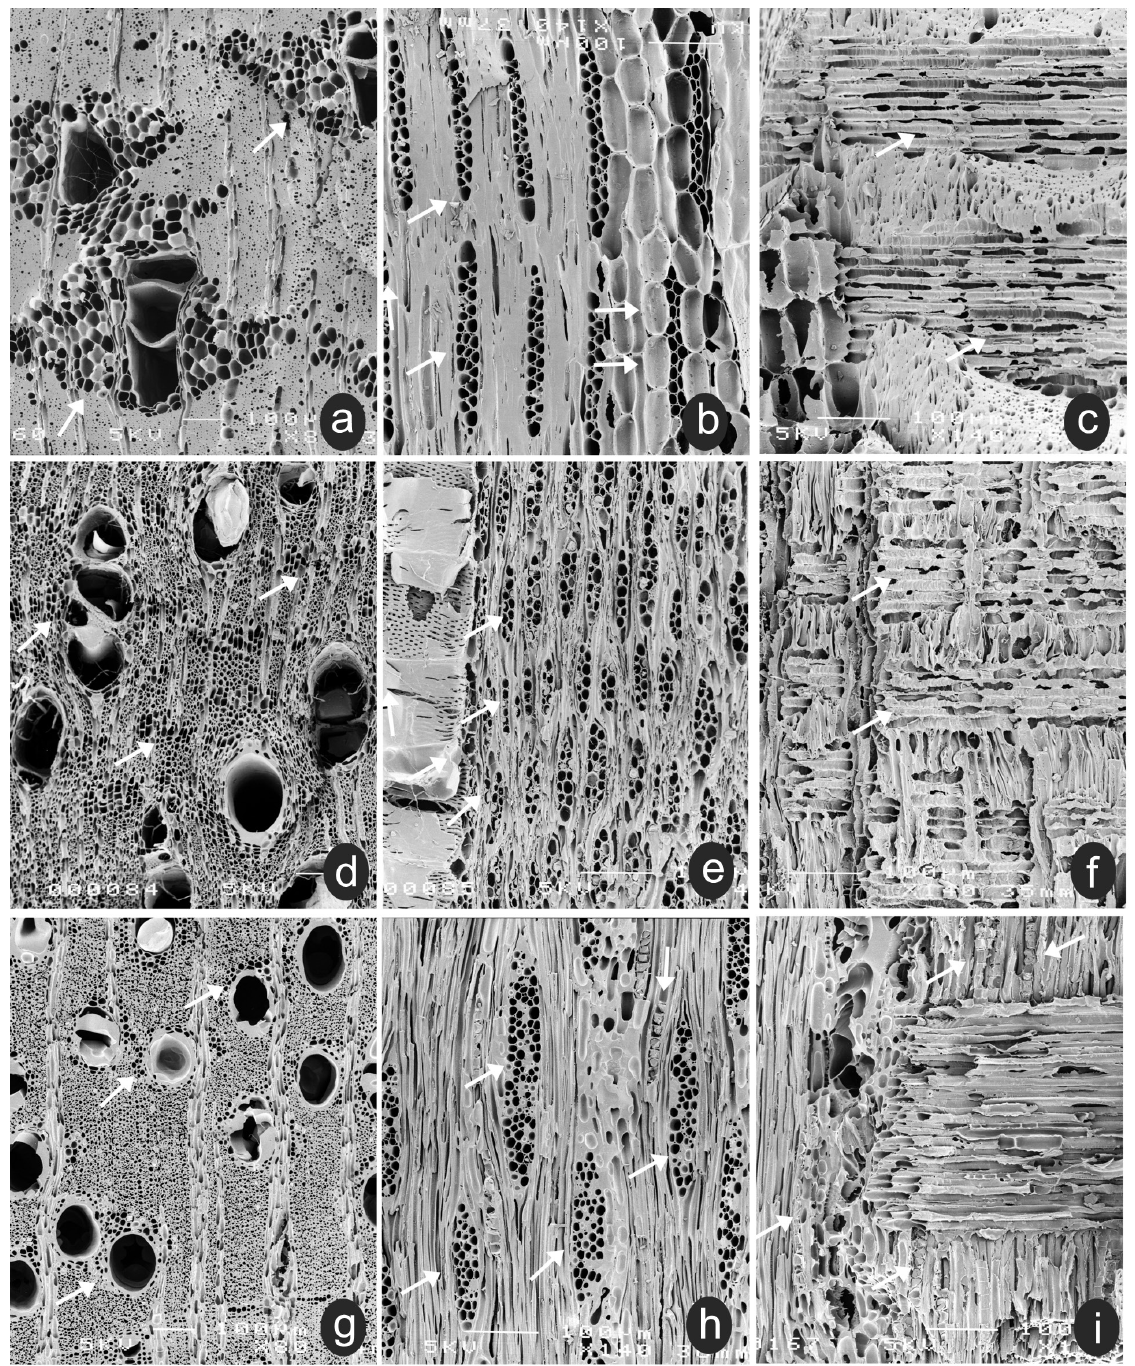
Figure 4. a-b-c. Bowdichia virgilioides Kunth. (Fabaceae Faboideae / SPSFw1148) [Arrows: a- axial parenchyma; b- storied rays; storied parenchyma cells (right arrows); c- procumbent ray cells]. d-e-f. Dalbergia nigra (Vell.) Allemão ex Benth. (Fabaceae Faboideae / BCTw s/nº) [Arrows: d- aliform axial parenchyma; e- storied rays; f- ray cells]. g-hi Anadenanthera colubrina var. cebil (Griseb.) Altschul (Fabaceae Mimosoideae / SPSFw1121) [Arrows: g- vasicentric axial parenchyma; h- rays; axial alignment of prismatic crystals (vertical arrow); i axial alignments of prismatic crystals]. a-d-g: Transverse section. – b-e-h: Tangential section. – c-f-i Radial section. Bars = 100